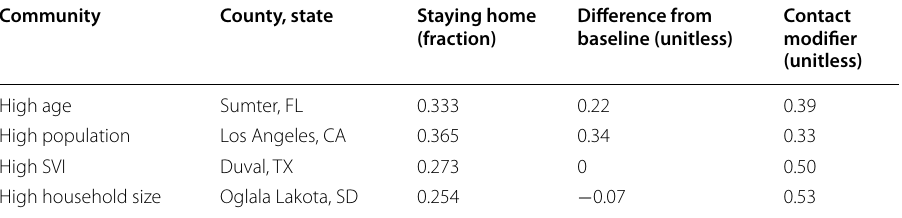
Difference from Contact (fraction) baseline (unitless) modifier (unitless)